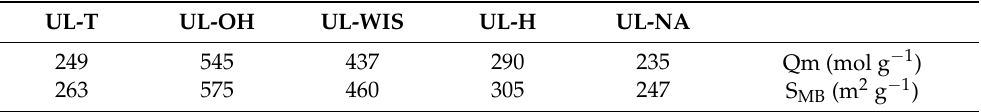
Table 1. Characteristics of the adsorbents: untreated, water insoluble substance, and treated dry U. actuca